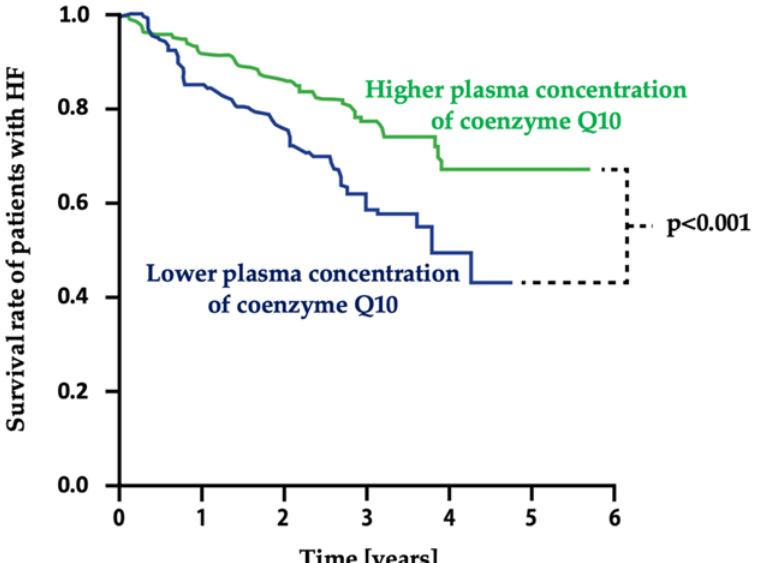
Figure 6. Relationship between plasma concentration of coenzyme Q10 in patients with HF and survival. Based on information from [27]. HF — heart failure .